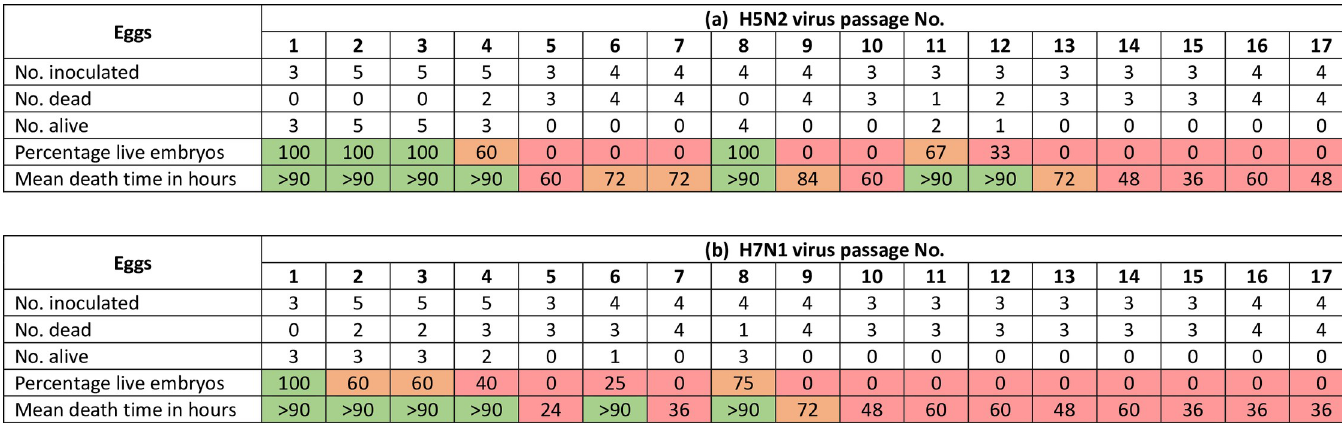
Fig 1. Mortality patterns and mean death times (MDTs) of (a) H5N2 and (b) H7N1 low pathogenic avian influenza viruses passaged in 14-day old embryonated eggs. A 100% survival rate and MDTs > 90 hours are coloured green. Survival rates between 50 and 100% and MDTs between 60 and 90 hours are coloured orange. Survival rates less than 50% and MDTs of 60 hours and less are coloured